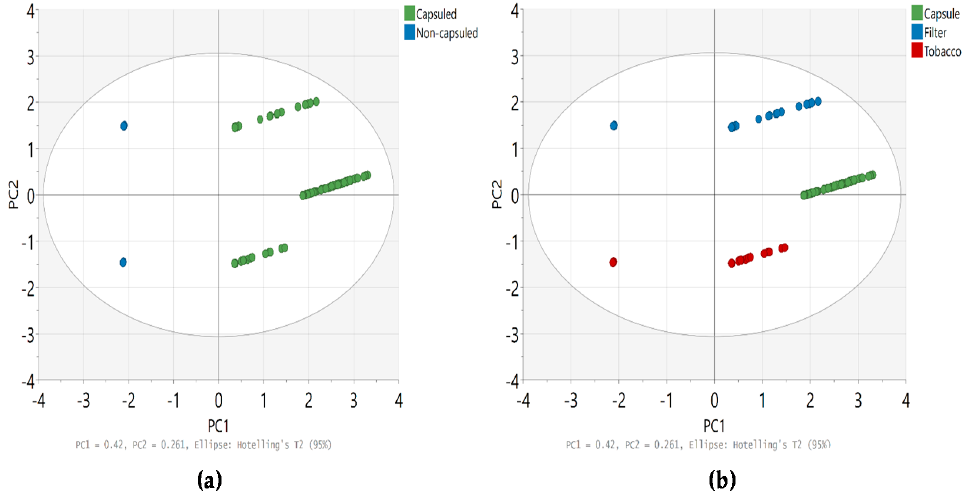
Figure 4. PCA for content ( µ g/cigarette) of flavoring agents in cigarettes ( a ) capsule cigarette vs. non-capsule cigarette; ( b ) tobacco, filter tip, and capsule.